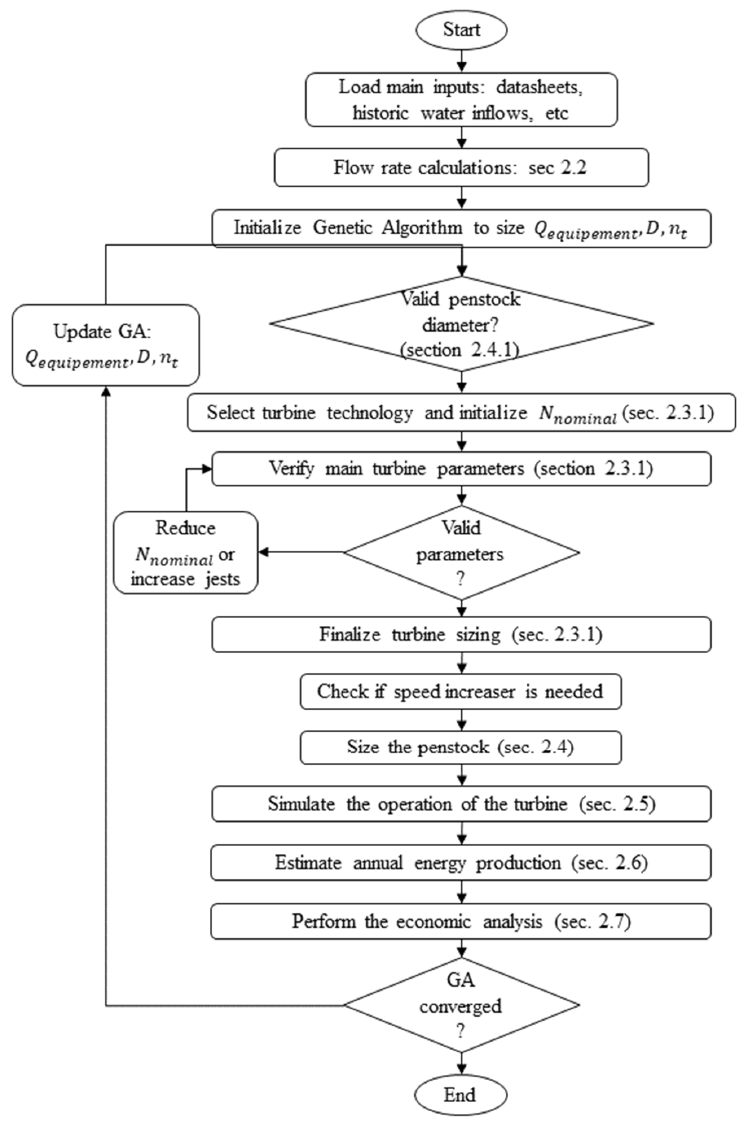
Figure 6. Optimization process minimizing LCOE.